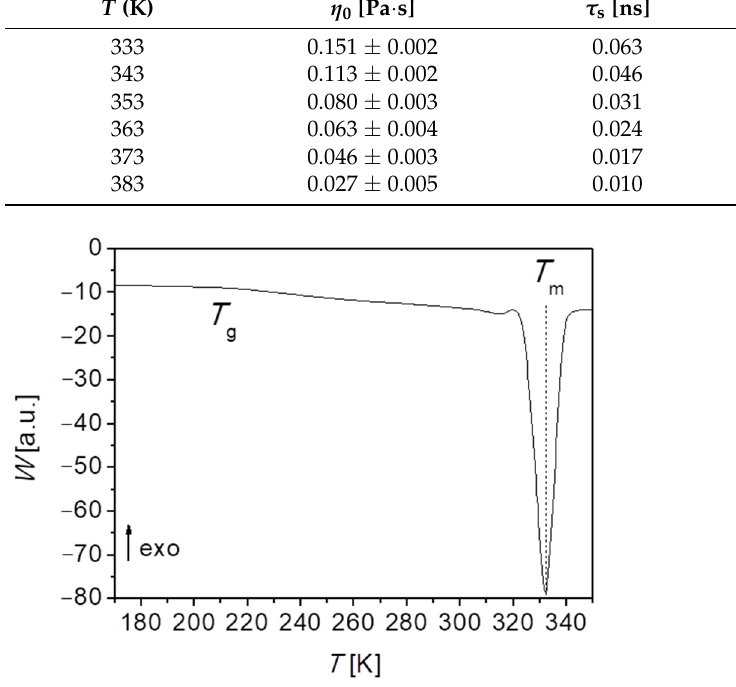
Table 2. Zero-shear viscosity η 0 (averaged over different shear rates in the Newtonian region), segmental relaxation time τ s and Rouse time τ R , at different temperatures for our PEG polymer block. T (K) η 0 [Pa · s] τ s [ns] τ R [ns] 333 0.151 ± 0.002